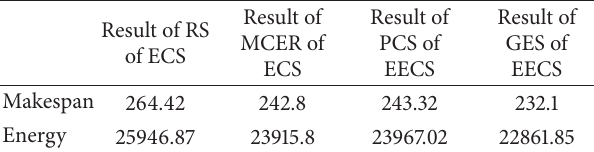
Table 5: The schedule results of EECS and ECS for 𝐺 . Table 6: Experimental